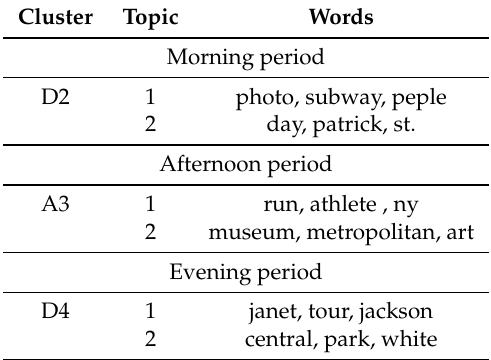
Table 8. Cluster topic samples from the NY